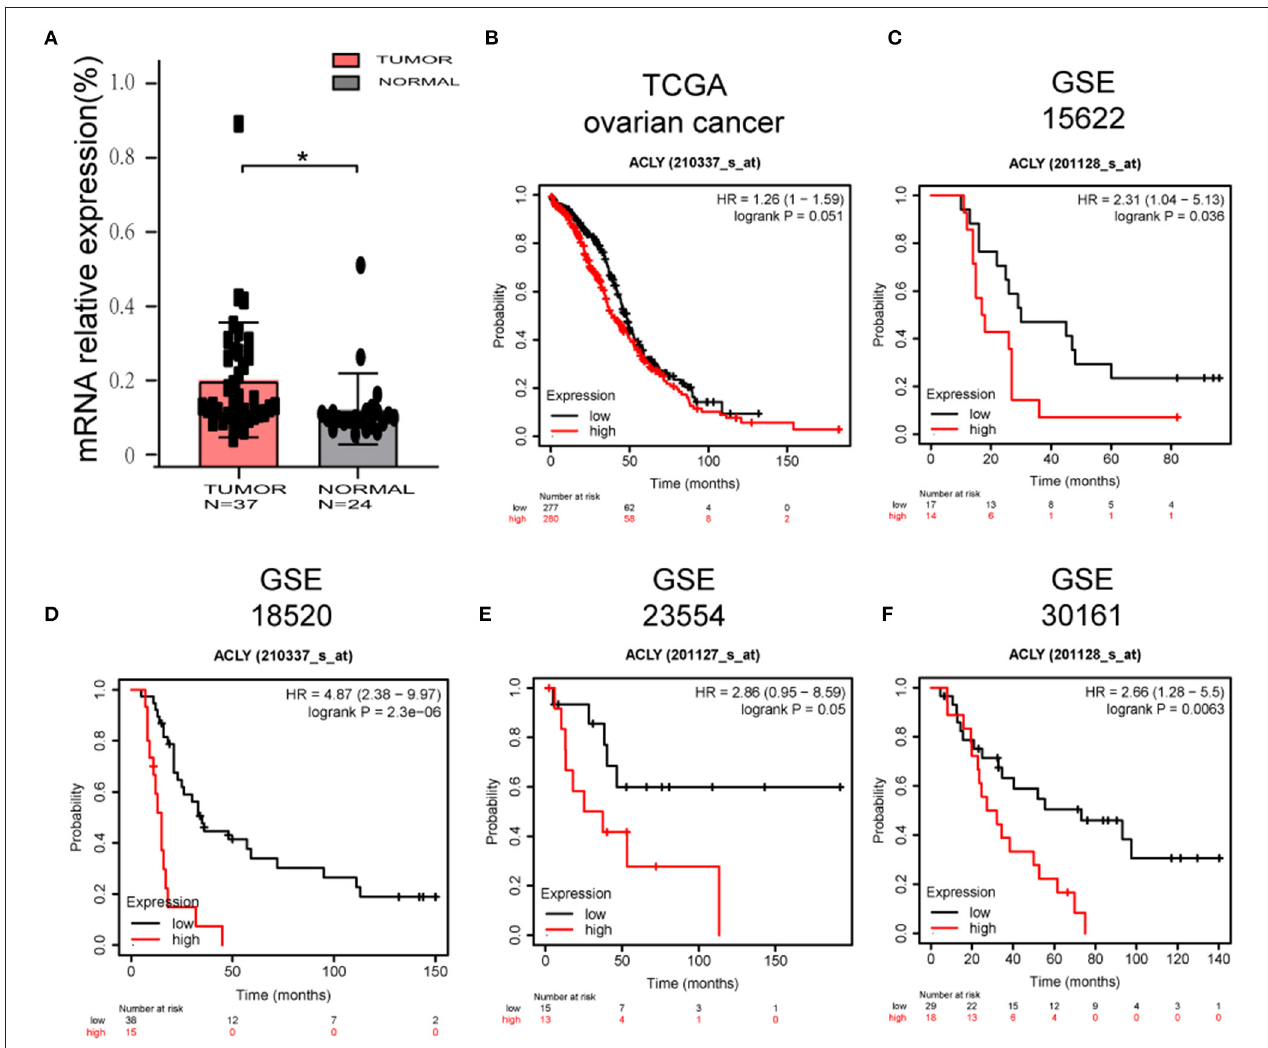
FIGURE 1 | ACLY was upregulated in ovarian cancer tissues, and its expression was associated with poor prognosis. (A) The comparison of ACLY expression between high grade serous ovarian cancer tissues ( N = 47) and fallopian tube epithelium ( N = 24) of patients from Qilu hospital. Statistical analysis was performed using Student’s t -test. * P < 0.05. (B–F) Overall survival analysis based on ACLY expression (high-expression group vs. low-expression group) of TCGA ovarian cancer cohort, GSE15622 dataset, GSE18520 dataset, GSE23554 dataset, GSE30161 dataset. * P < 0.05 for statistical analysis of the indicated